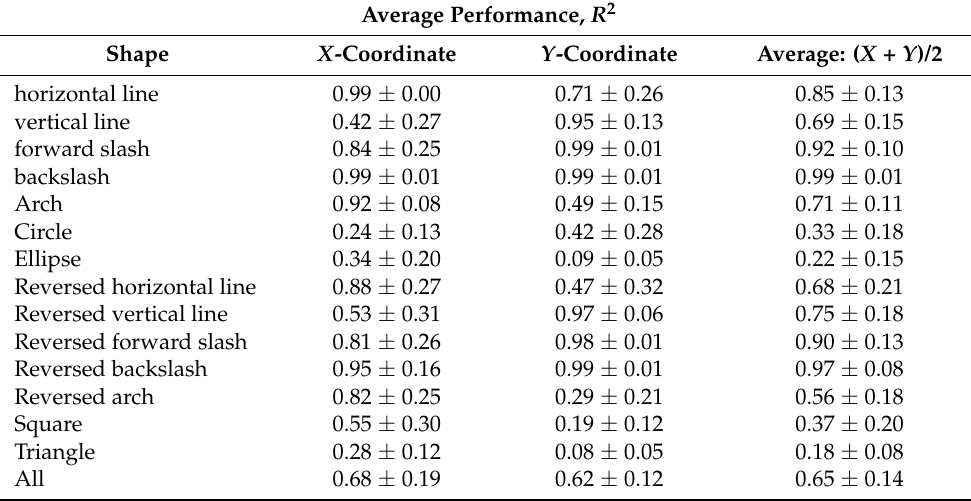
Table 2. Within-group reconstruction performance by the KF-GEP: the average accuracy of each shape across the five subjects.